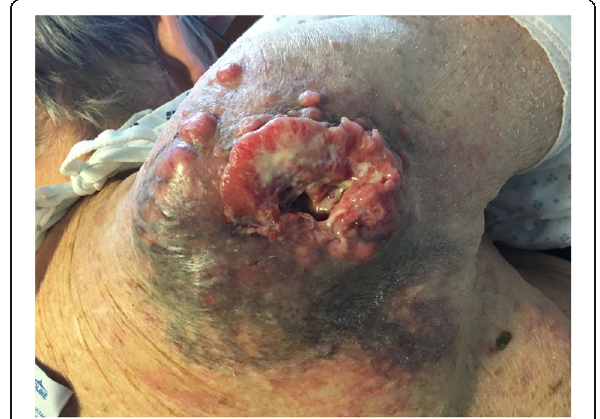
Fig. 4 Carcinoembryonic antigen (CEA) immunostain has a membranous pattern around a subset of tumor cells and highlights irregular ductal